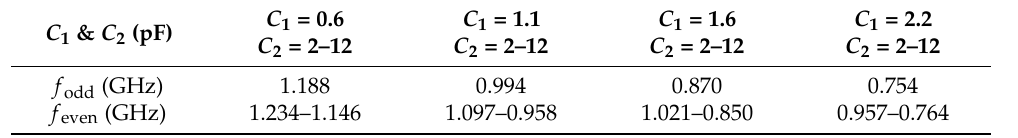
Table 1. Tuning range of f even and f odd as C 1 and C 2 vary. Y 1 = 0.01 S, Y 2 = Y 3 = 0.02 S, θ 1 = 55°, θ 2 = 25° and θ 3 = 5° at 1 GHz.